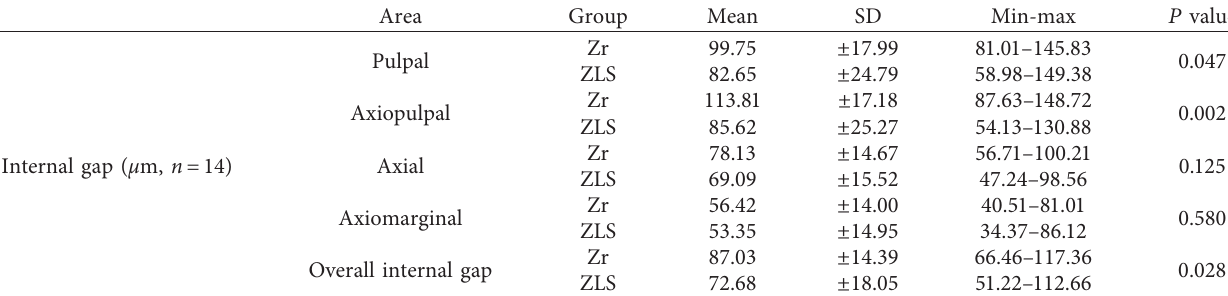
Table 2: Internal gap results.